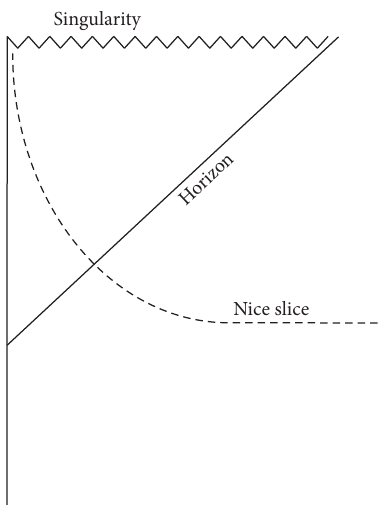
Figure 1: Schematic of a single “nice slice” crossing a black hole